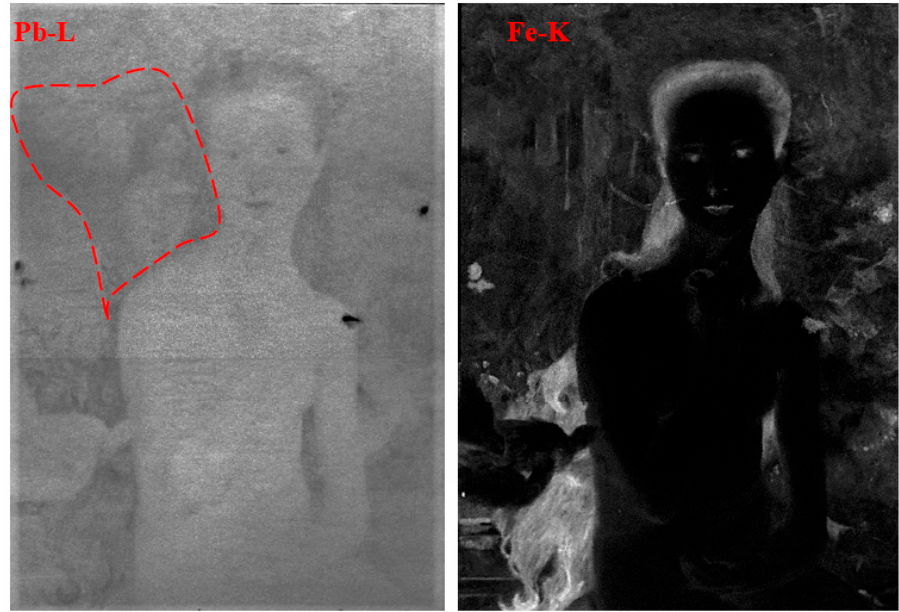
Figure 7. Pb-L and Fe-K elemental maps of painting “ Gioventú ” by Eliseu Visconti. On the Pb-L map, an underlying painting is shown.